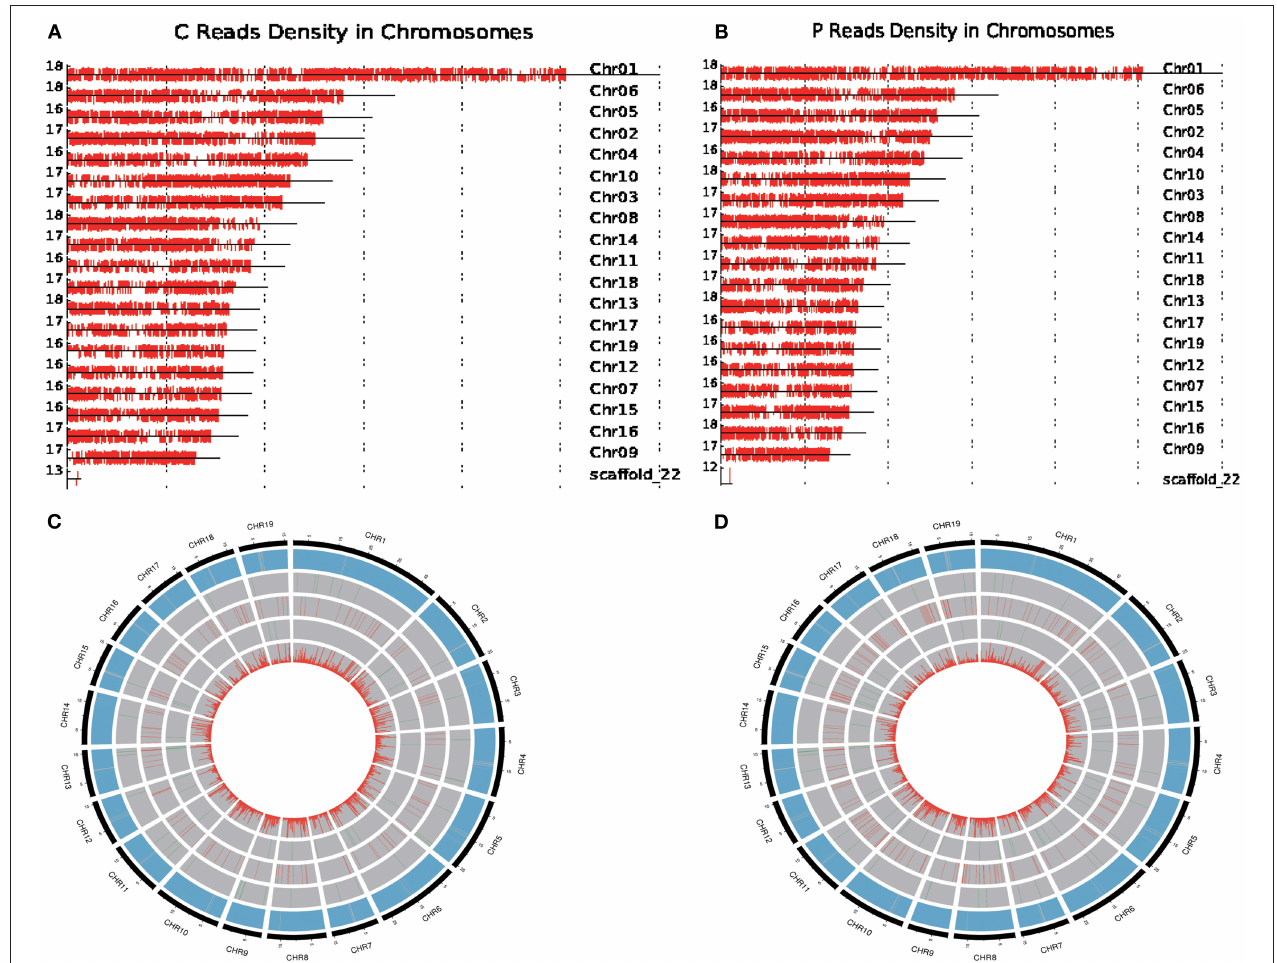
FIGURE 3 | Circos visualization of PacBio Isoseq data in P. trichocarpa and P. ussuriensis compared using SMRT sequencing. (A,B) Distribution of full-length reads density in P. trichocarpa . and P. ussuriensis, respectively, on reference chromosome, respectively. (C,D) The distribution of genetic variants in P. trichocarpa . and P. ussuriensis ,